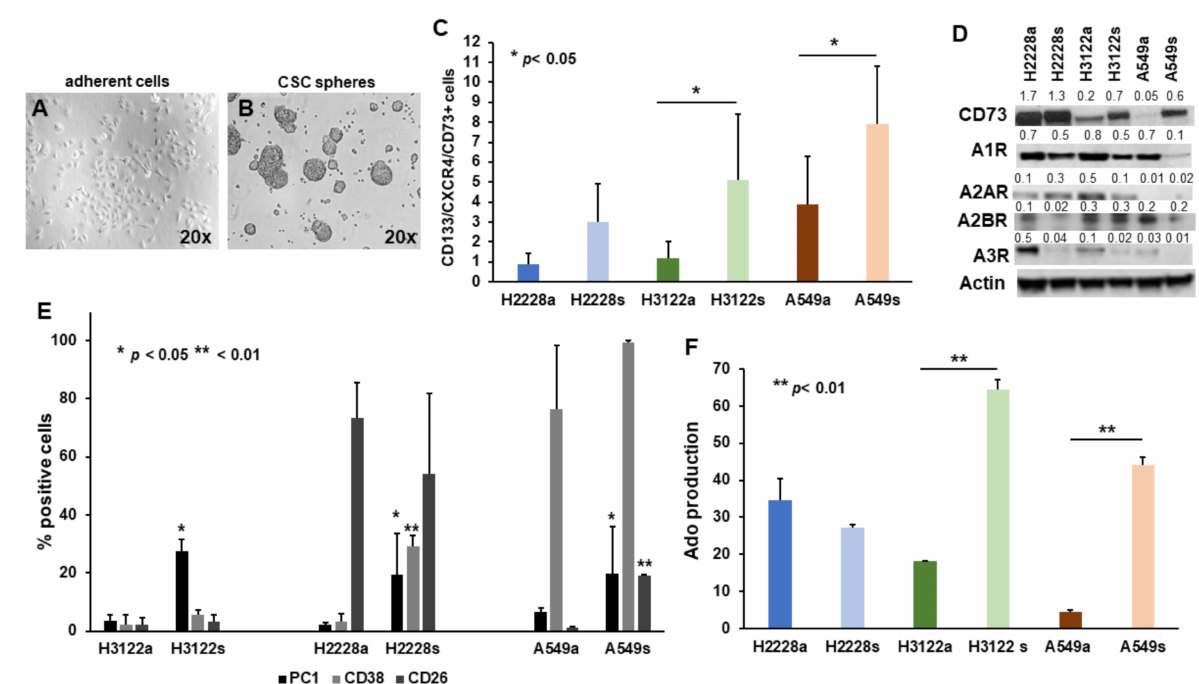
Figure 1. CD73 and Ado production by NSCLC cells. Images show NSCLC cell lines grown as adher- ent cells ( A ) and as as spheres, when cultured in the specific serum-free medium ( B ). ( C ) The subset of stem cells expressing CD133/CXCR4 was also highly positive for CD73, with a significantly increased expression for H3122s and A549s compared to the adherent counterparts, p < 0.05. ( D ) Western blot analysis confirmed the up-regulation of CD73 in NSCLC spheres compared to the adherent counterpart and showed the expression of the different Ado P1 purinergic receptors. Quantification of each band is reported ( E ). The graph reports the level of expression CD38, PC1, and CD26, which were basically up-regulated in NSCLC spheres compared to the adherent cells; data are the mean value ± SD of three analyses for each cell line. ( F ) Bars indicate the quantification of Ado production, as mean area % of the peaks ± SD, showing a significantly increased Ado production by H3122 and A549 spheres, p < 0.05. Student’s t -test was performed to compare adherent cells and